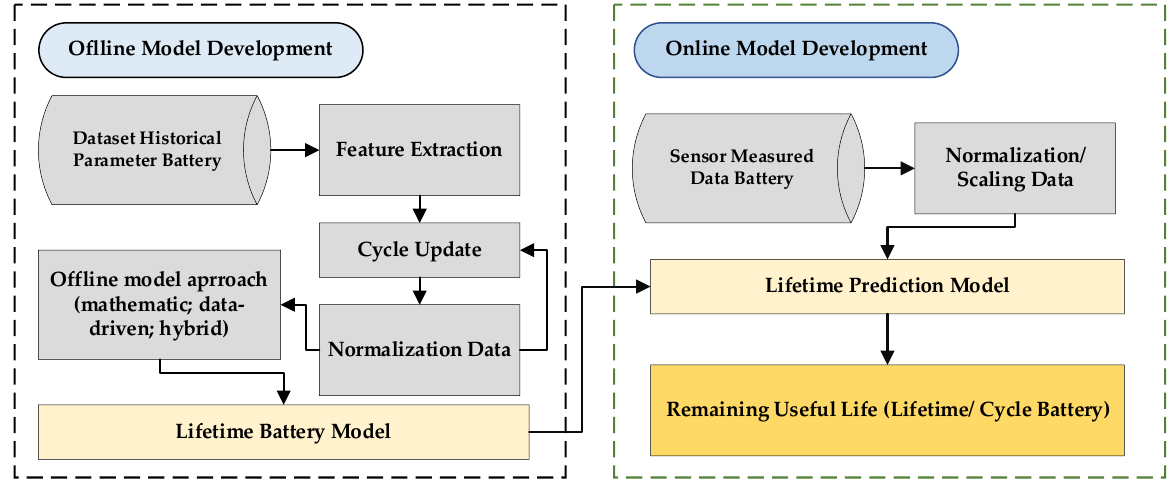
Figure 7. Block diagram of RUL prediction in general.